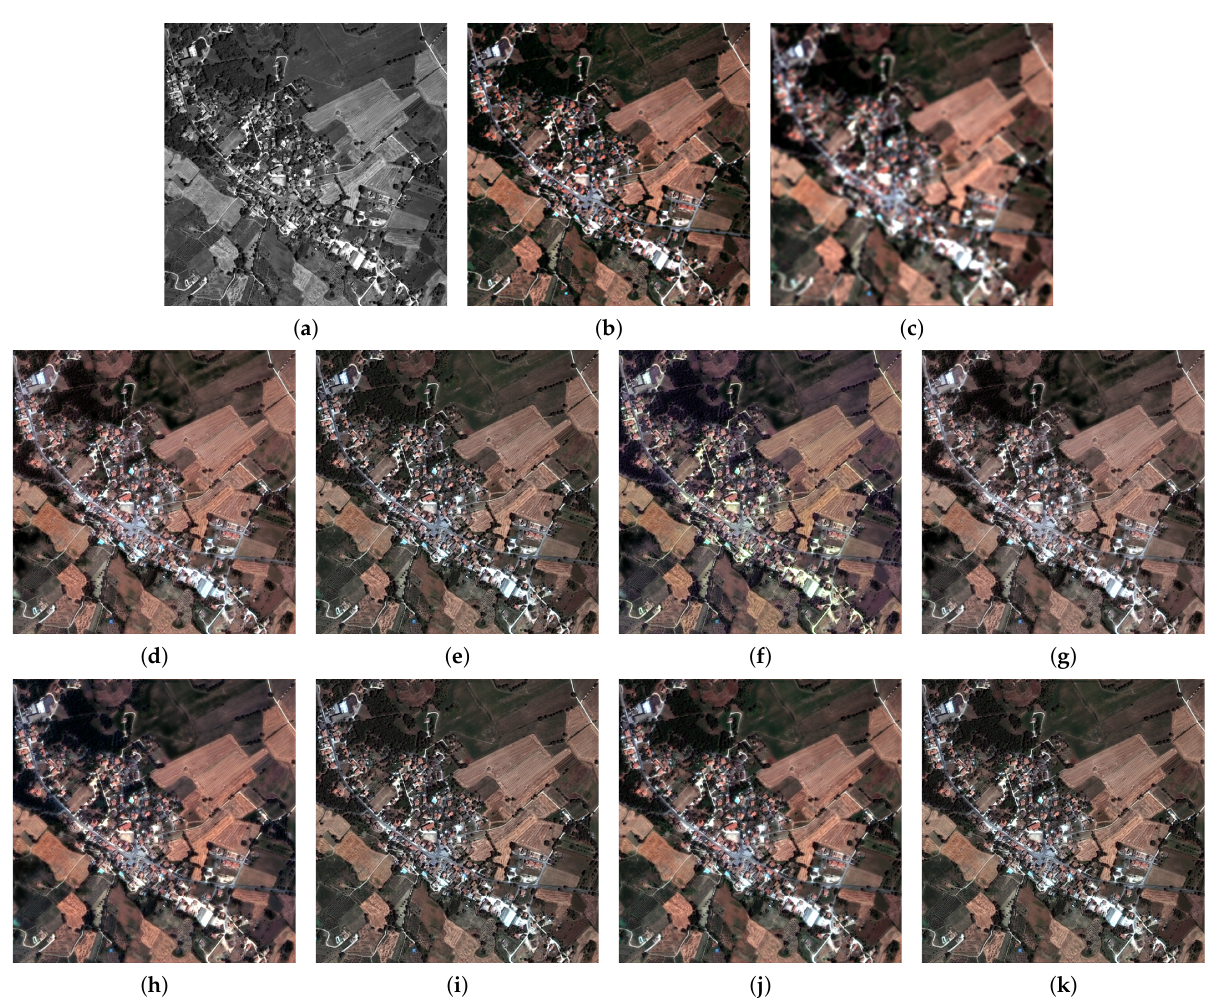
Figure 5. Fusion results at reduced resolution, using a true-color representation, for the Collazzone dataset: ( a ) Pan image; ( b ) reference; ( c ) expanded; ( d ) GS; ( e ) GSA; ( f ) GIHS; ( g ) PCA; ( h ) BT; ( i ) MTF-GLP; ( j ) BDSD; ( k )